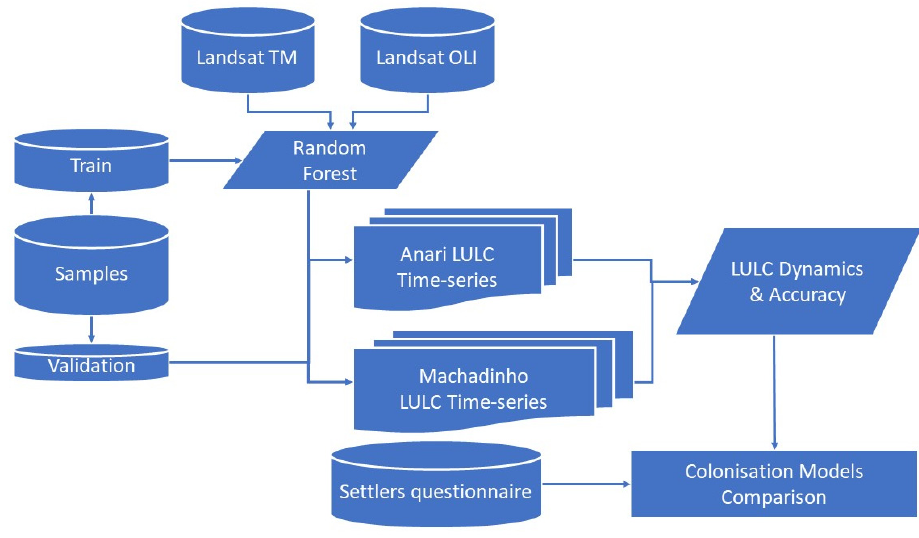
Figure 2. Methodology used in this